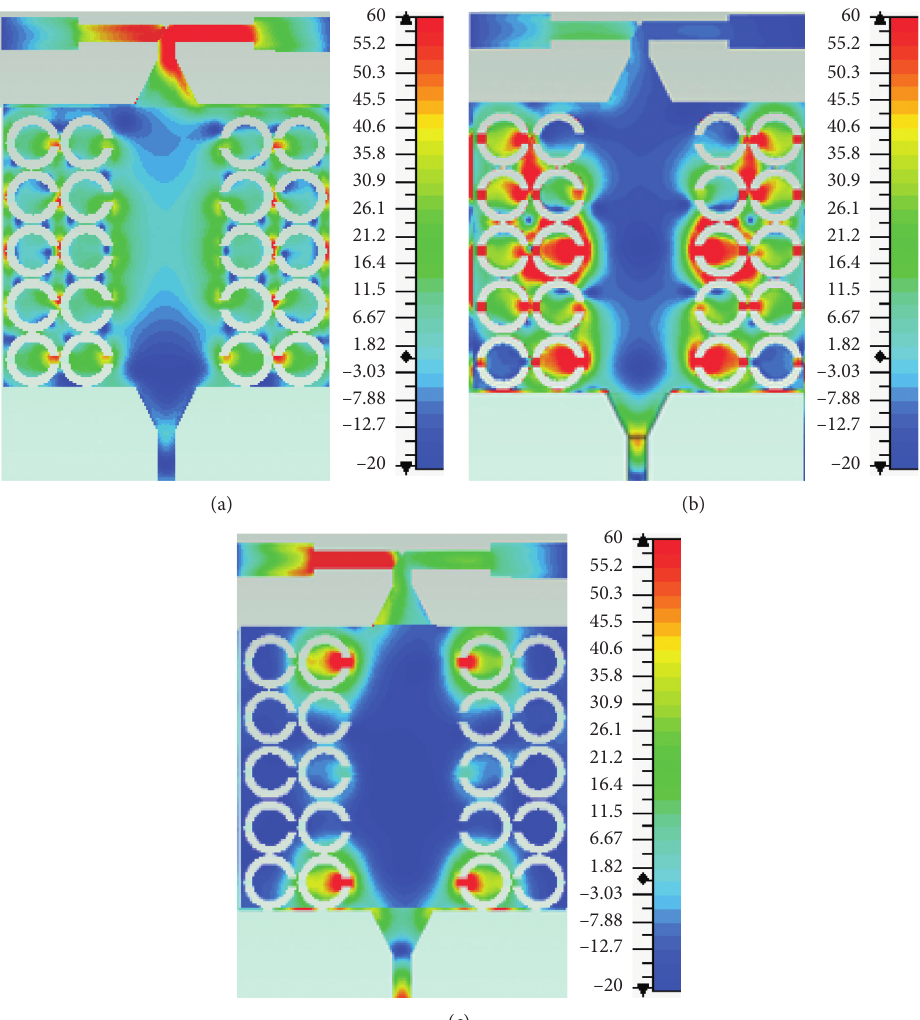
Figure 2: The current distribution at different frequencies over the antenna: (a) 2.4GHz, (b) 5.2 GHz, and (c) 5.7GHz.